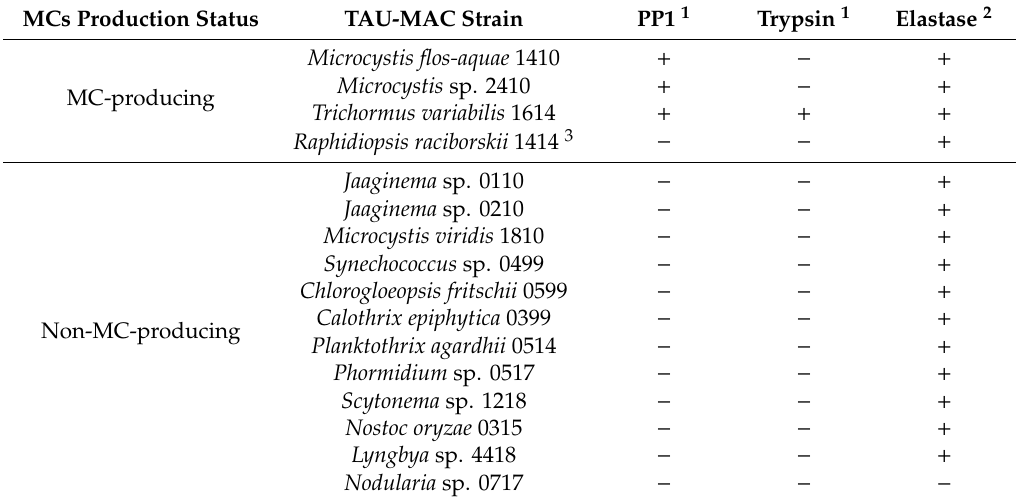
Table 1. Inhibitory e ff ects of the cyanobacterial extracts on PP1, trypsin, and elastase, with reference to each strain. “ + ”: inhibition; “ − “: no e ff ect.